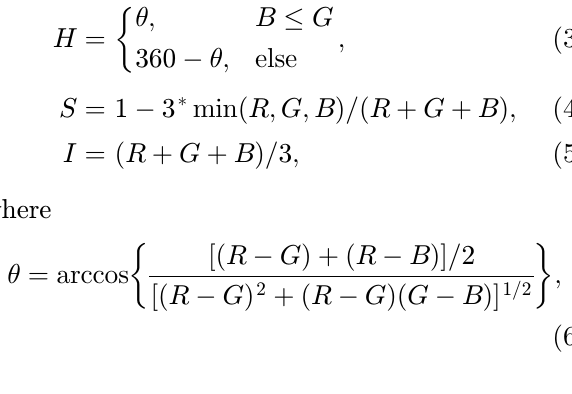
Fig. 2. H component